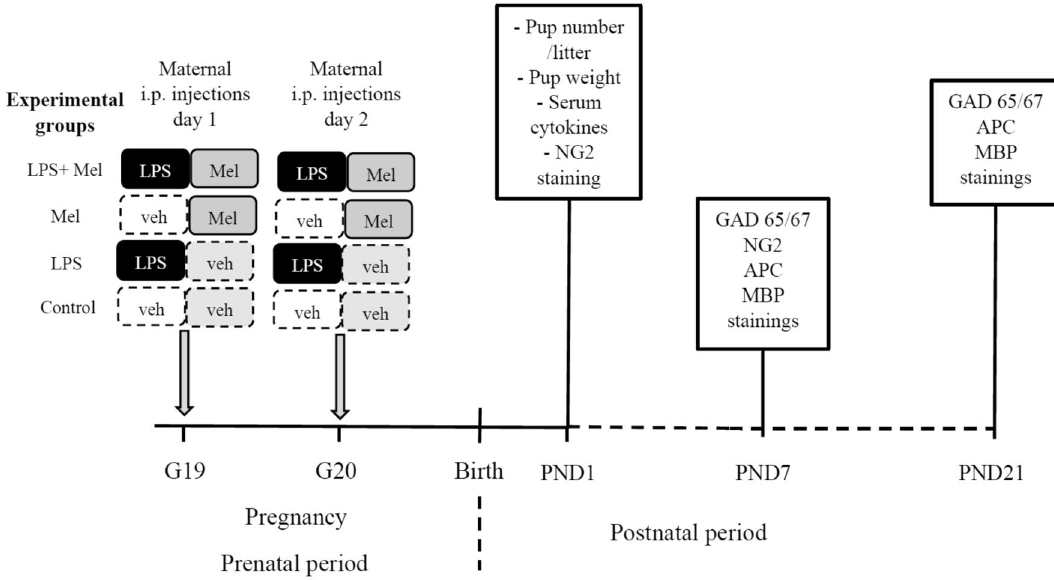
Figure 6. Experimental schedule. G: Gestational day, LPS: Liposaccharide portion of E. coli membrane, Mel: Melatonin, Veh: vehicle, i.p.: intraperitoneal, PND: Postnatal